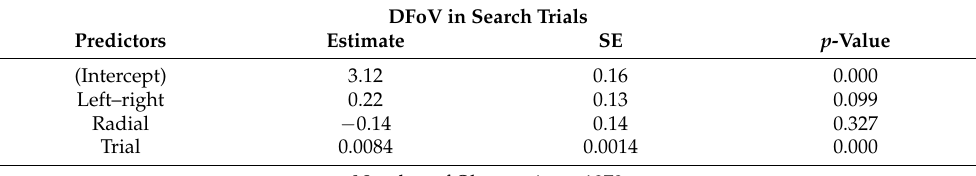
Table A4. Results of the analysis of DFoV in search trials. The applied model was a linear mixed- effects model that considered both random intercept and random slope.